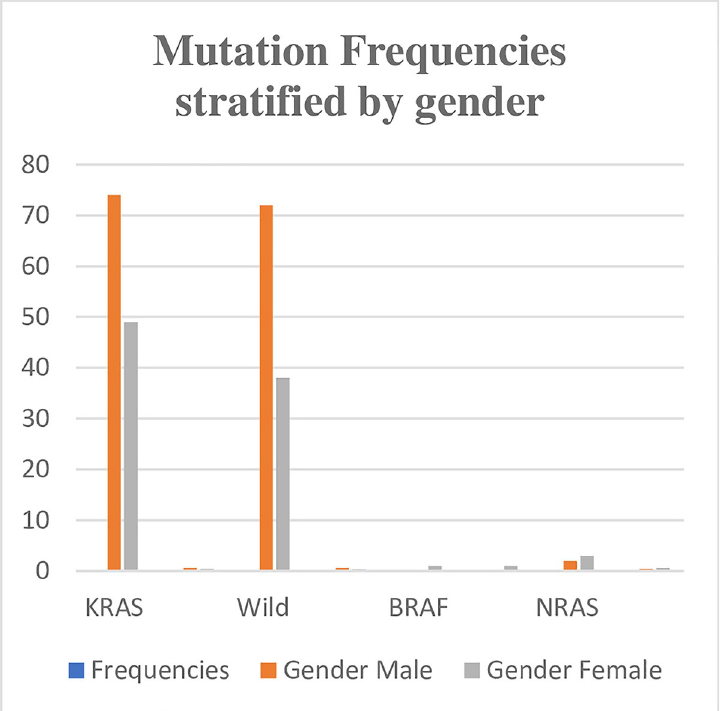
Fig 1. Distribution of mutation frequency of KRAS , NRAS and BRAF genes among 248 CRC patients stratified by gender.